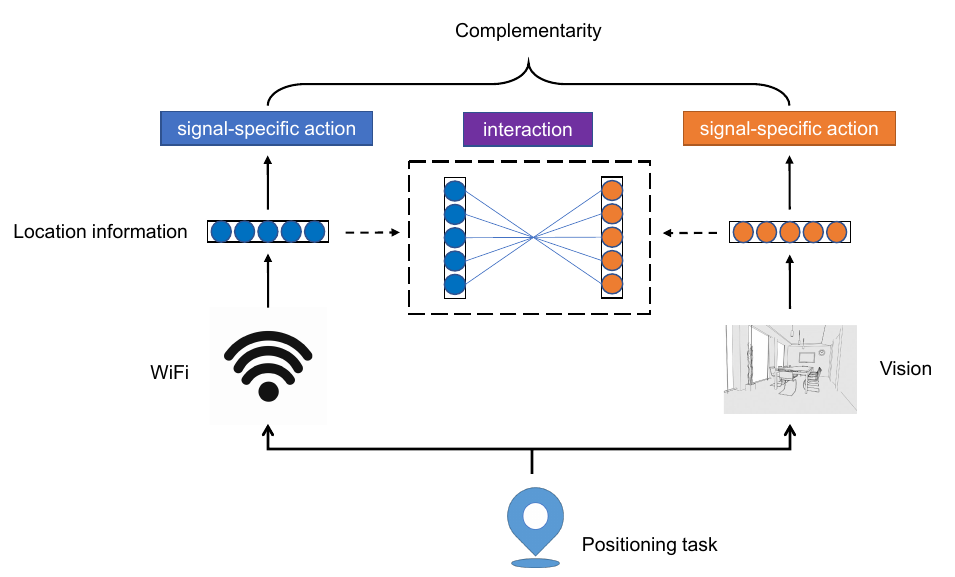
Figure 1. Explanation of the complementarity of WiFi and vision in positioning tasks. We argue that the complementarity of WiFi and vision in positioning tasks are fully reflected in the signal-specific actions and interaction of their location